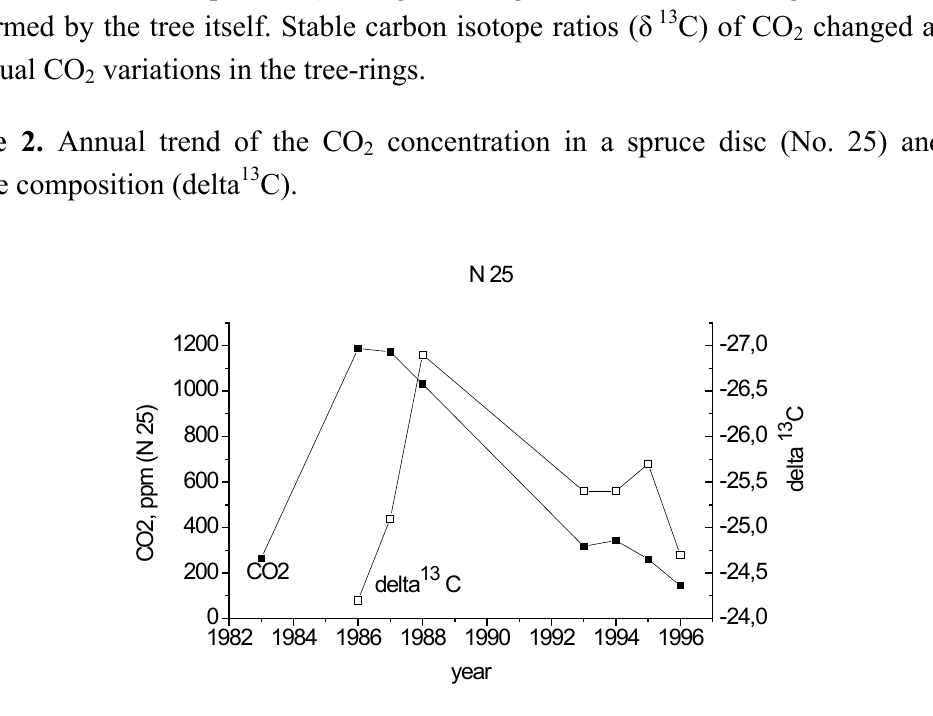
concentration in a spruce disc (No. 25) and δ 13 C 2